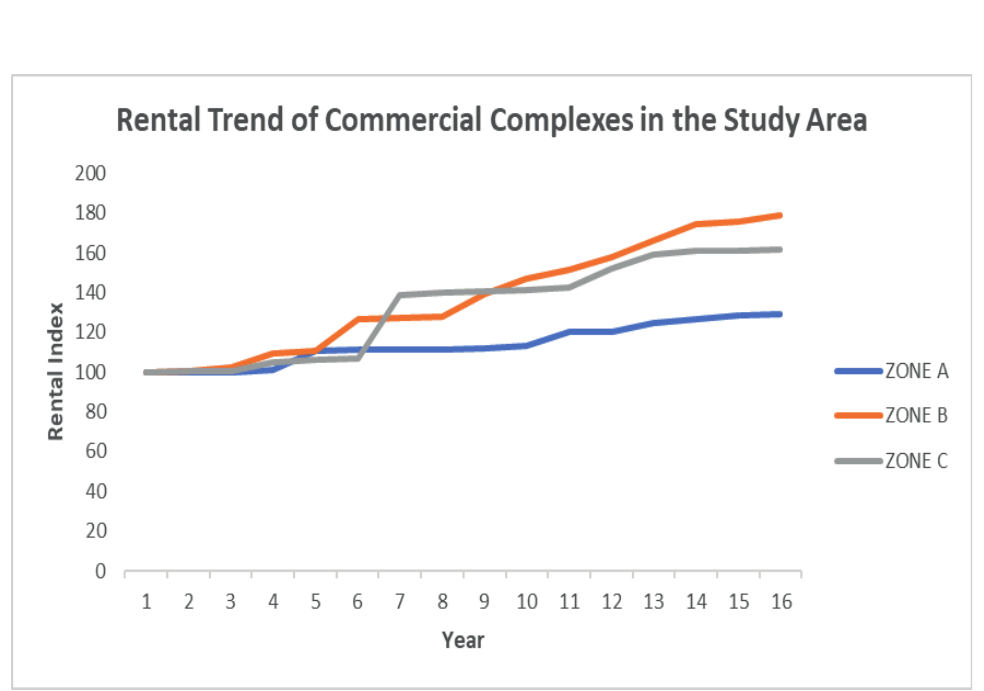
Fig. 1. Rental trend of commercial complexes in the study area, 2005–2020.